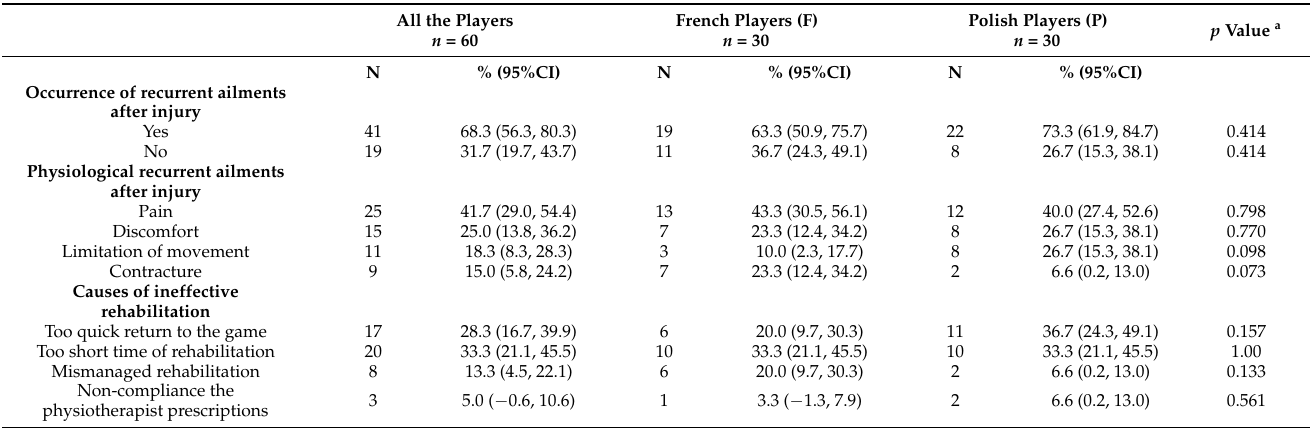
Table 7. The subjective evaluation of the rehabilitation procedures reported by rugby players ( n =